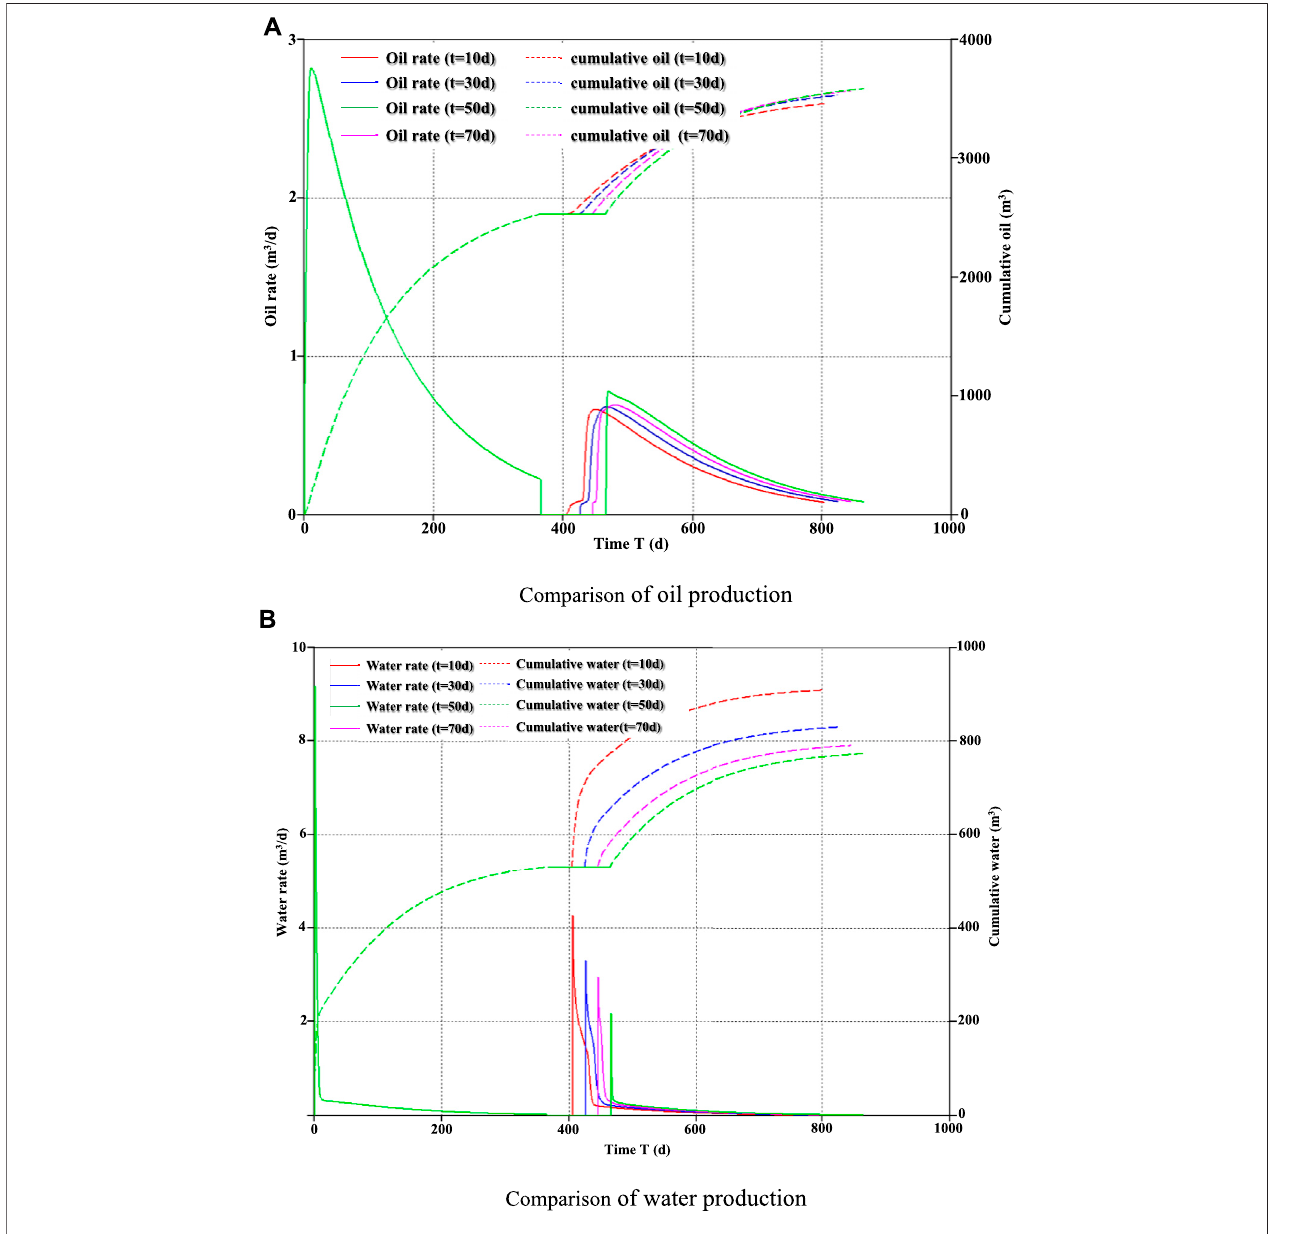
FIGURE 12 | Comparison of oil and water production with different soak time. (A) Comparison of oil production. (B) Comparison of water production.